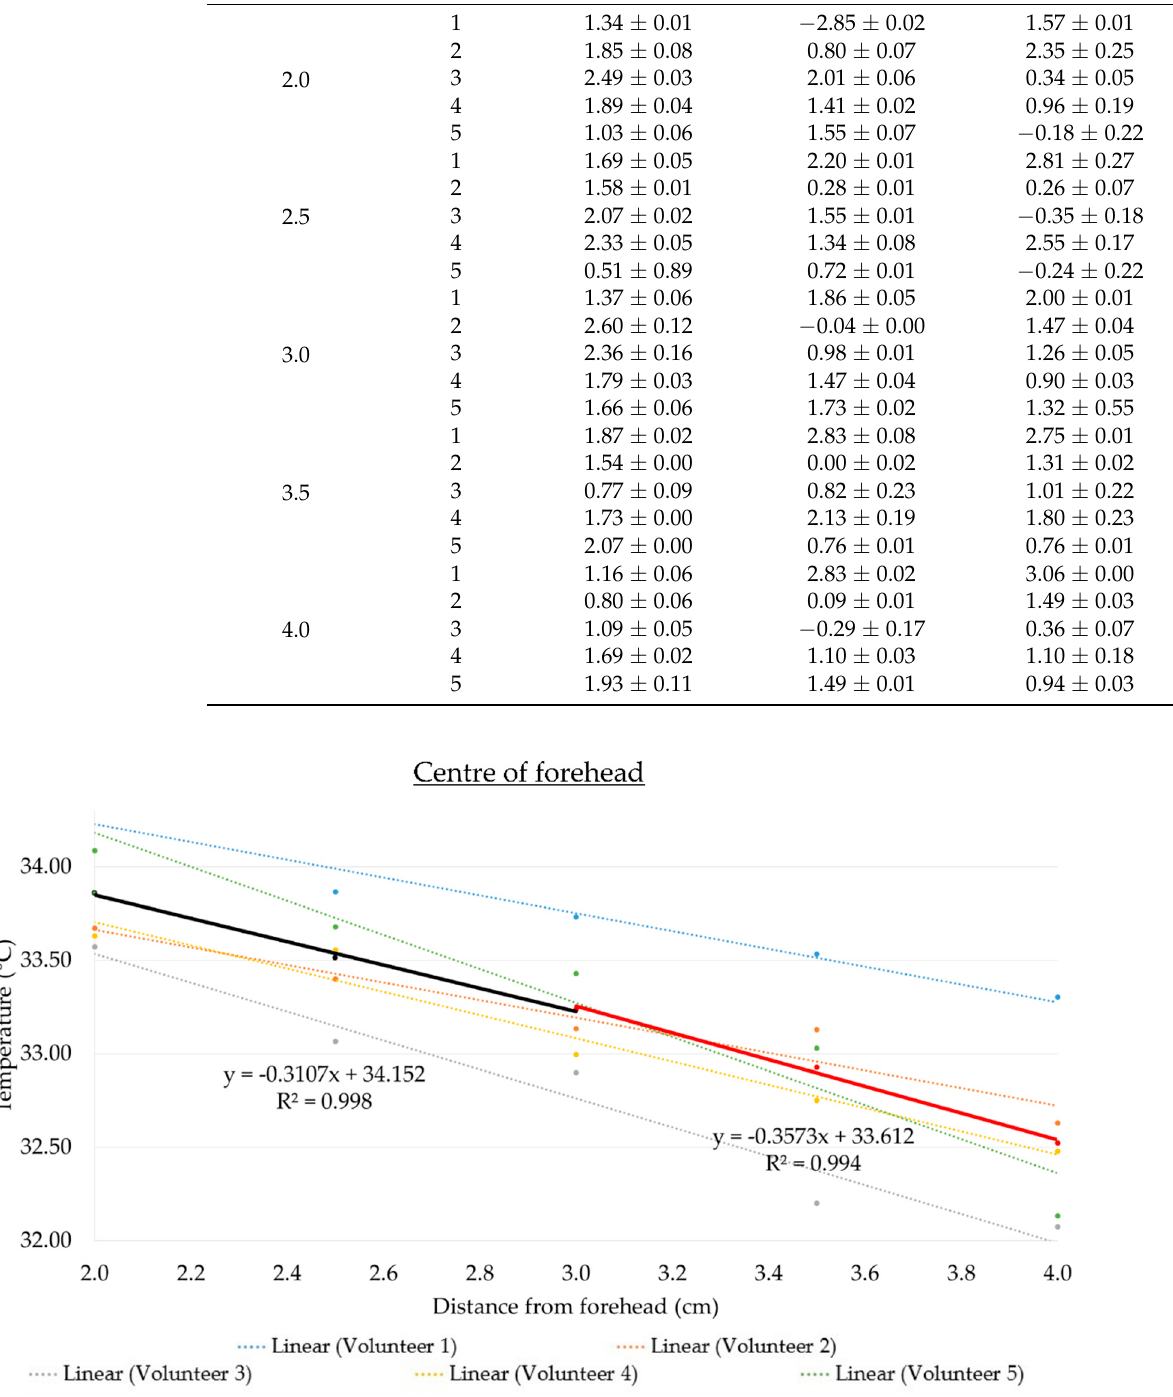
Figure 5. Combined trend lines for all the volunteers between 2–3 cm (in black) and between 3–4 cm (in red).